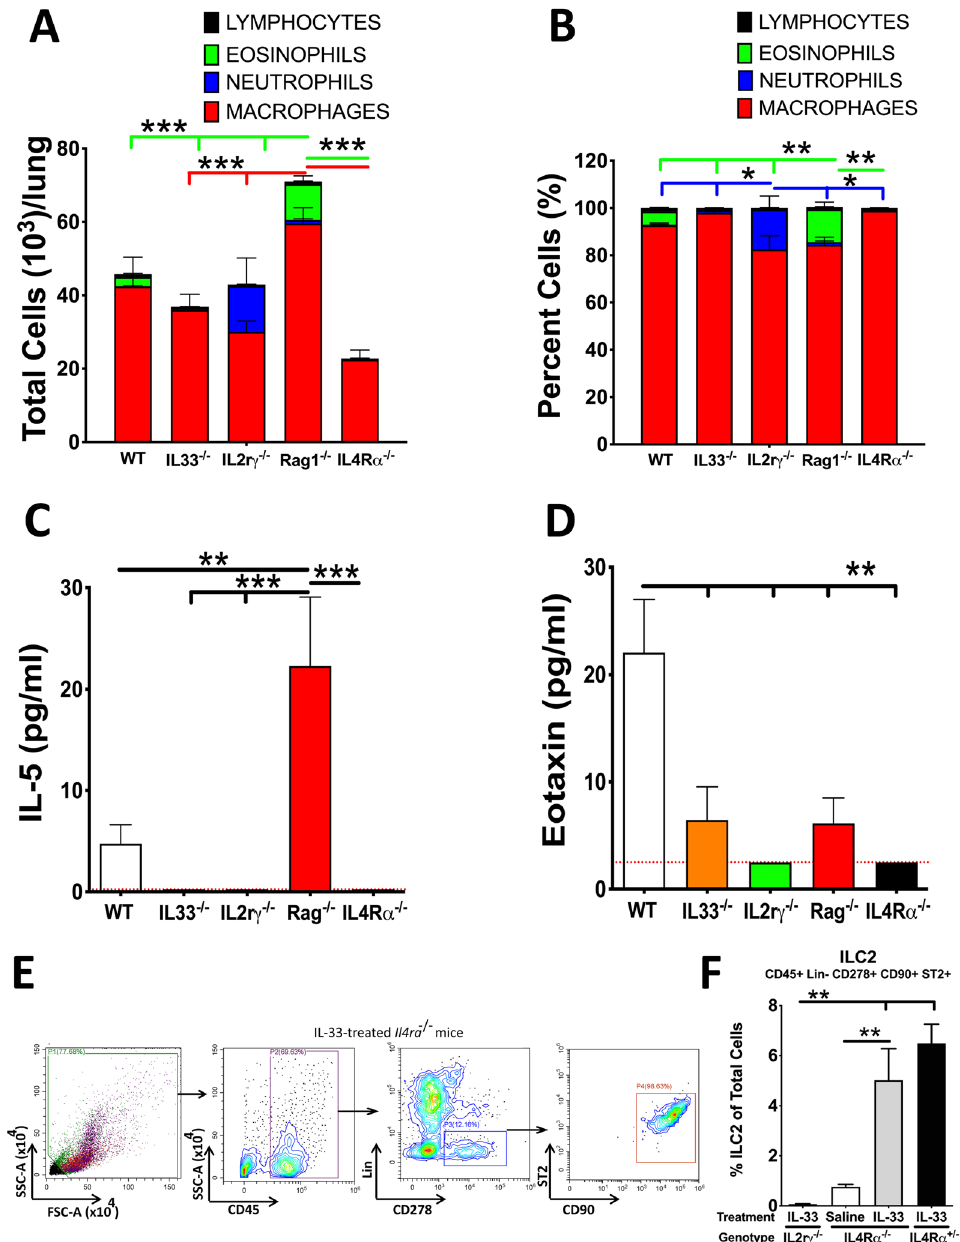
Figure 2. Airspace eosinophilia is regulated by the innate lymphoid system. Cell counts in BALF from 10-day- old wildtype (WT), IL-33 −/− , IL2rγ −/− , Rag1 −/− , and IL4Rα −/− neonates (n = 5–14 per group). Differential cell counts ( A ) and relative percentages of constituent cell types ( B ) are shown as stacked bar graphs [macrophages (red), neutrophils (blue), eosinophils (green), and lymphocytes (black)]. Cytokine levels (pg/ml) of IL-5 (C) and Eotaxin ( D ) in cell-free BALF from 10-day-old wildtype, IL-33 −/− , IL2rγ −/− , Rag1 −/− , and IL4Rα −/− neonates (n = 5 per group). The lower limits of detection (indicated by red dotted lines) for IL-5 and Eotaxin were 0.25 pg/ml and 2.51 pg/ml, respectively. Error bars represent SEM. ** p < 0.01, *** p < 0.001 using ANOVA followed by Tukey’s multiple comparison post hoc test. ( E ) Gating Strategy and representative scatter plots for flow cytometric characterization of ILC2’s (CD45 + Lin - CD278 + CD90.2 + ST2 + ) in whole-lung single-cell suspension from IL-33-treated IL4Rα −/− mice (n = 3 per group). ( F ) Percentage of ILC2s in whole-lung single- cell suspension from IL-33-treated IL2rγ −/− , saline-treated IL4Rα −/− , IL-33-treated IL4Rα −/− , and IL-33-treated IL4Rα +/- mice. Error bars represent SEM. ** p < 0.01, using ANOVA followed by Tukey’s multiple comparison post hoc test. The results represent cumulative data from mice generated in three different